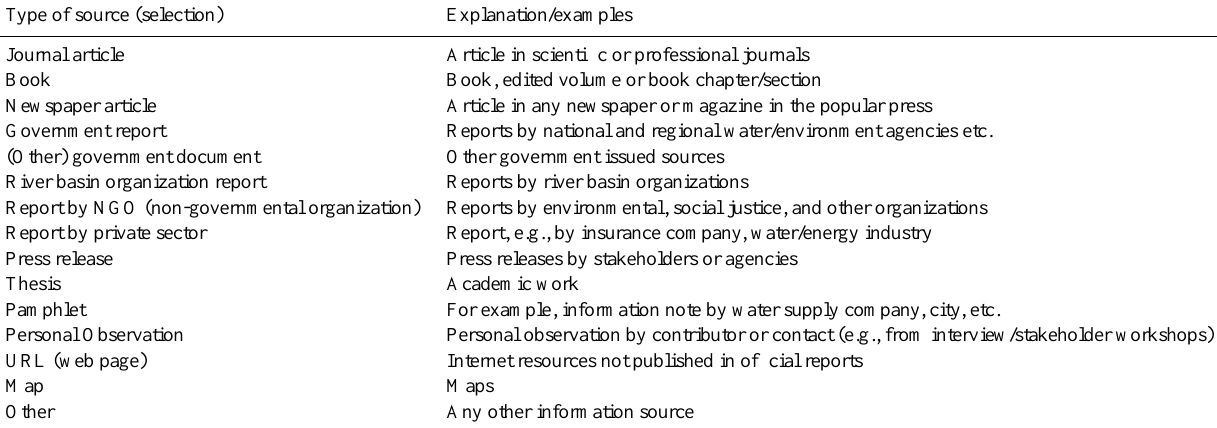
Table A1. Overview of information sources for drought impacts entered into the EDII (Stahl et al.,